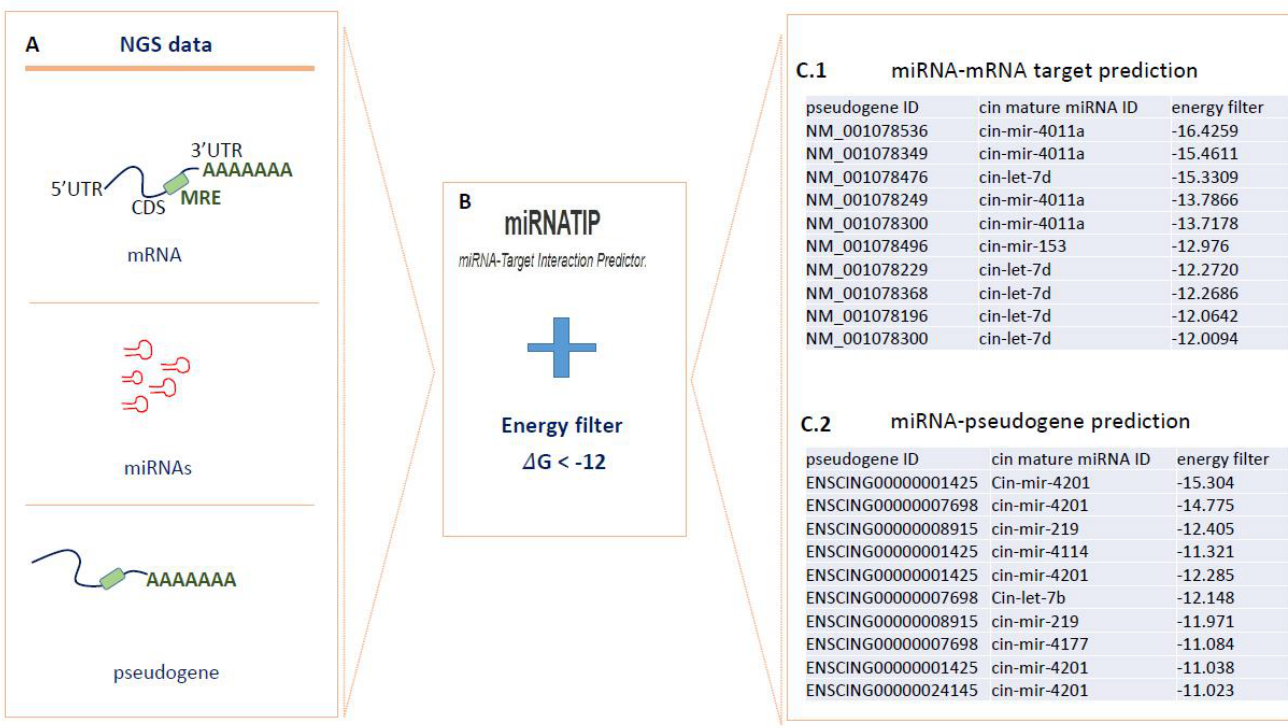
Figure 4. Prediction of mRNA–miRNA and miRNA–pseudogene interactions through the miRNATip algorithm. In ( A – C ), ( C.1 , C.2 ) are represented respectively the steps of the used pipeline: ( A ) different transcripts produced by NGS were analyzed by miRNATIP predictor. ( B ) miRNATIP computes interactions of a couple of RNA molecules (miRNA–mRNA and miRNA–pseudogenes). The predictions of all interactions are then filtered by the user through an energy filter of < − 12 of ∆ G. ( C.1 ) miRNA–mRNA target prediction results filtered for energy values. ( C.2 ) miRNA–pseudogenes prediction results filtered for energy values.